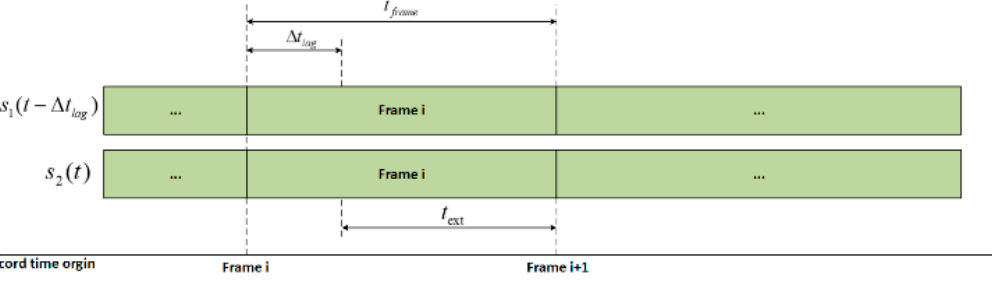
Figure 7. Frame division dependent on lag time.